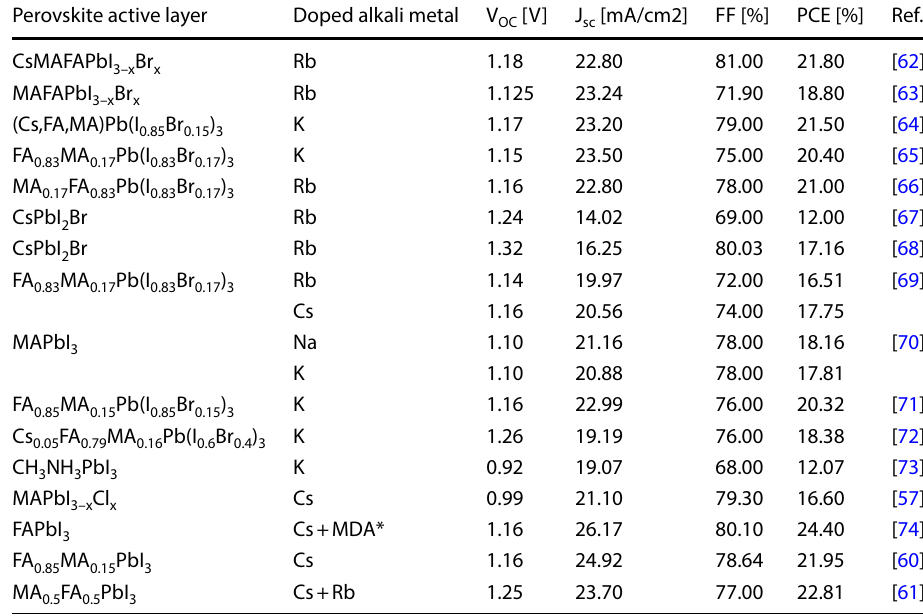
Table 1 Summary of alkali metal ions doped perovskite solar cell performance